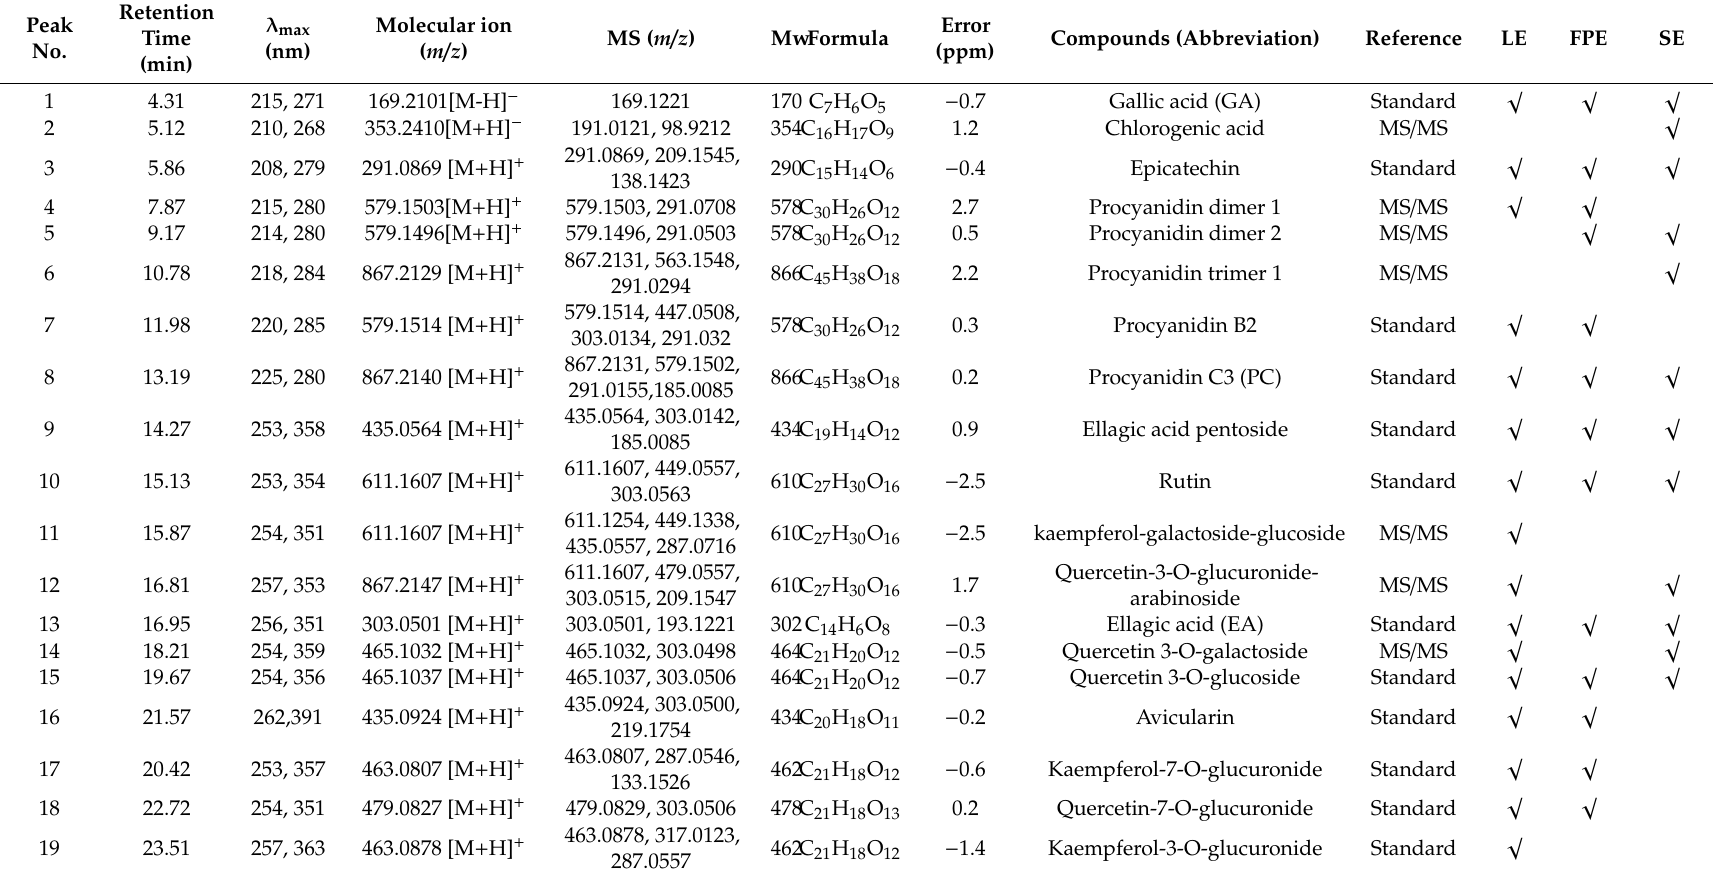
Table 1. Identification of phenolic compositions in various parts of raspberry by HPLC-ESI-HR-qTOF-MS / MS method.